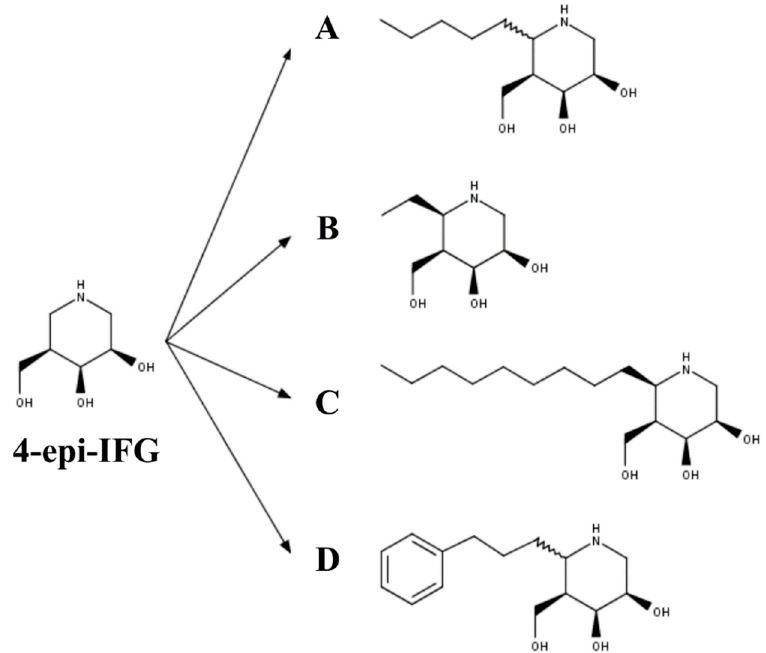
Figure 4. The 4- epi -isofagomine (4- epi -IFG) derived PC for GLB1 deficiency: ( A ) (5aS)- and (5aR)-5a-C-pentyl-4- epi -IFG; ( B ) 5a-C-methyl-4- epi -IFG; ( C ) 5a-C-nonyl-4- epi -IFG; and ( D ) 5a-C-2-phenylethyl-4- epi -IFG.